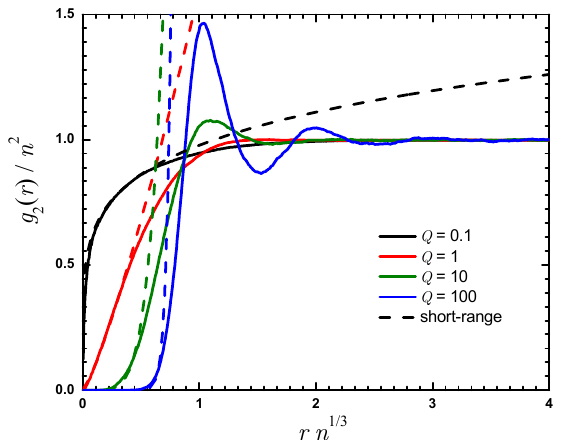
Figure 4. Pair distribution function in the gas phase for different values of Q = 0.1;1;10;100 (from top to bottom). Solid lines, Monte Carlo results; dashed lines, short-range expansion | r | 2 λ with the coefficient of proportionality fixed by a fitting procedure (see Equation (30)). Note that the point with Q = 100 corresponds to a metastable state, as the ground state in this regime is a solid.